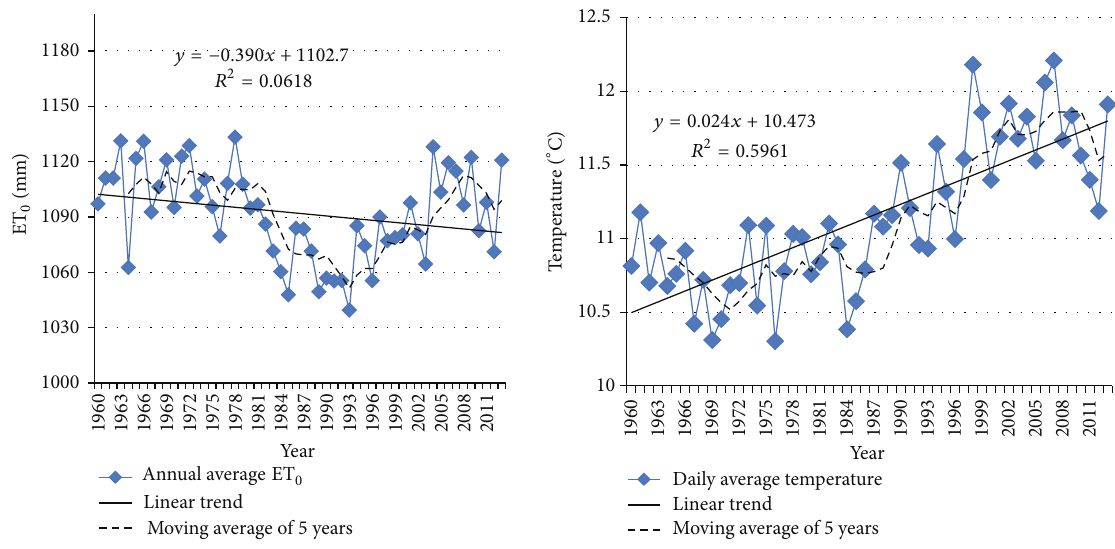
Figure 2: Interannual changes of temperature and ET 0 in